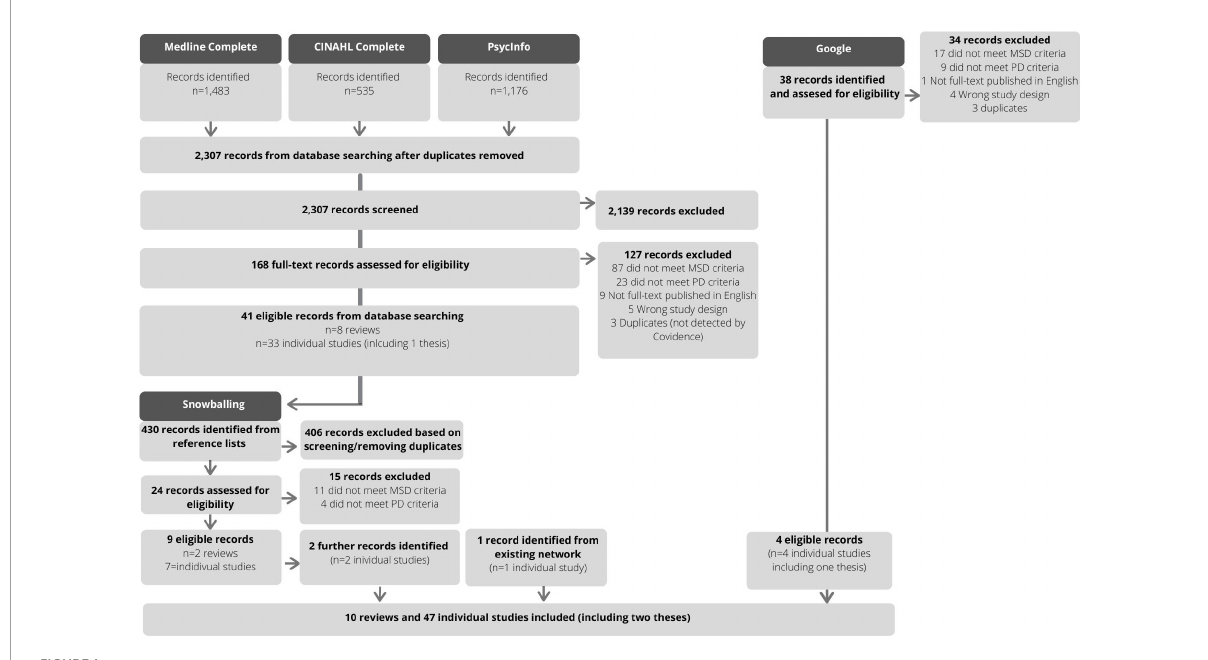
FIGURE1 Flow diagram of study identification and selection.